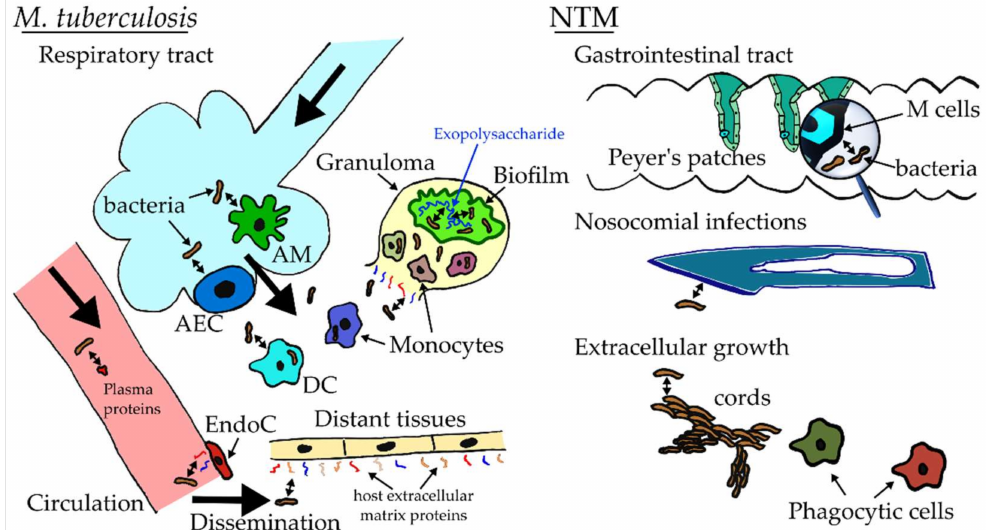
Figure 1. Where and when mycobacterial adhesion occurs during infection. Pulmonary infections involve initial adhesion to alveolar macrophages (AM) or epithelial cells (AEC). After transmigra- tion across the alveolar epithelium bacilli adhere to monocytic cells or dendritic cells (DC). The immune response can contain bacteria in granulomas, where it was very recently demonstrated that M. tuberculosis biofilms occur. Upon disintegration of granulomas, bacteria may adhere to extracel- lular matrix (ECM) components. During hematogenous dissemination, tubercle bacilli may bind plasma fibronectin and, ultimately, to ECM proteins to invade new tissues. Some nontuberculous mycobacteria (NTM) adhere to gut epithelium to cause gastrointestinal infections. NTM that cause nosocomial infections adhere to fomites or surgical equipment. Mycobacteria also self-adhere to form cords, which is a form of immune evasion employed by some NTM. EndoC, endothelial